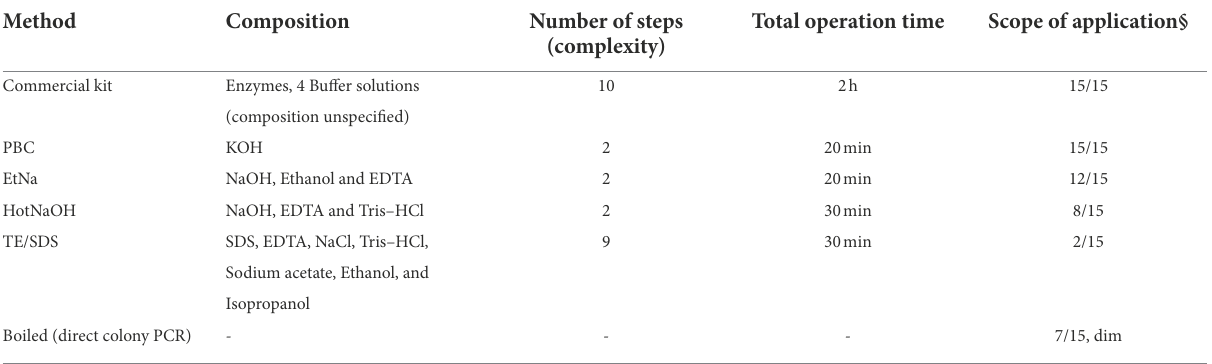
TABLE 3 Comparison among rapid DNA preparation methods.